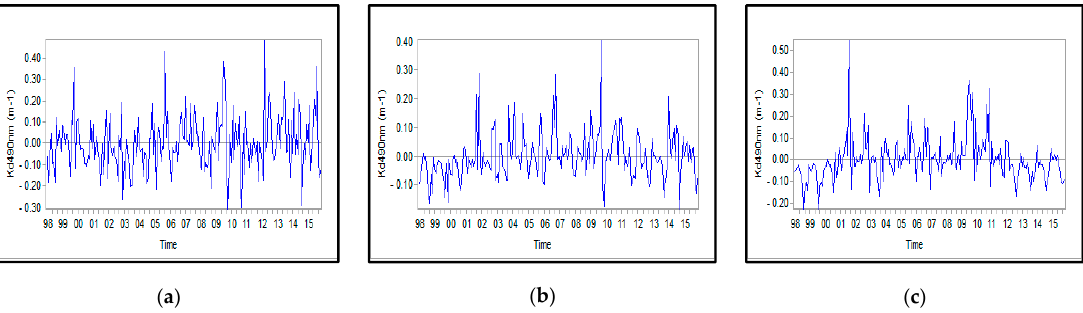
Figure A9. Monthly anomalies of the attenuation coefficient for: ( a ) Northern, ( b ) Middle, and ( c ) Southern Caspian Sea.